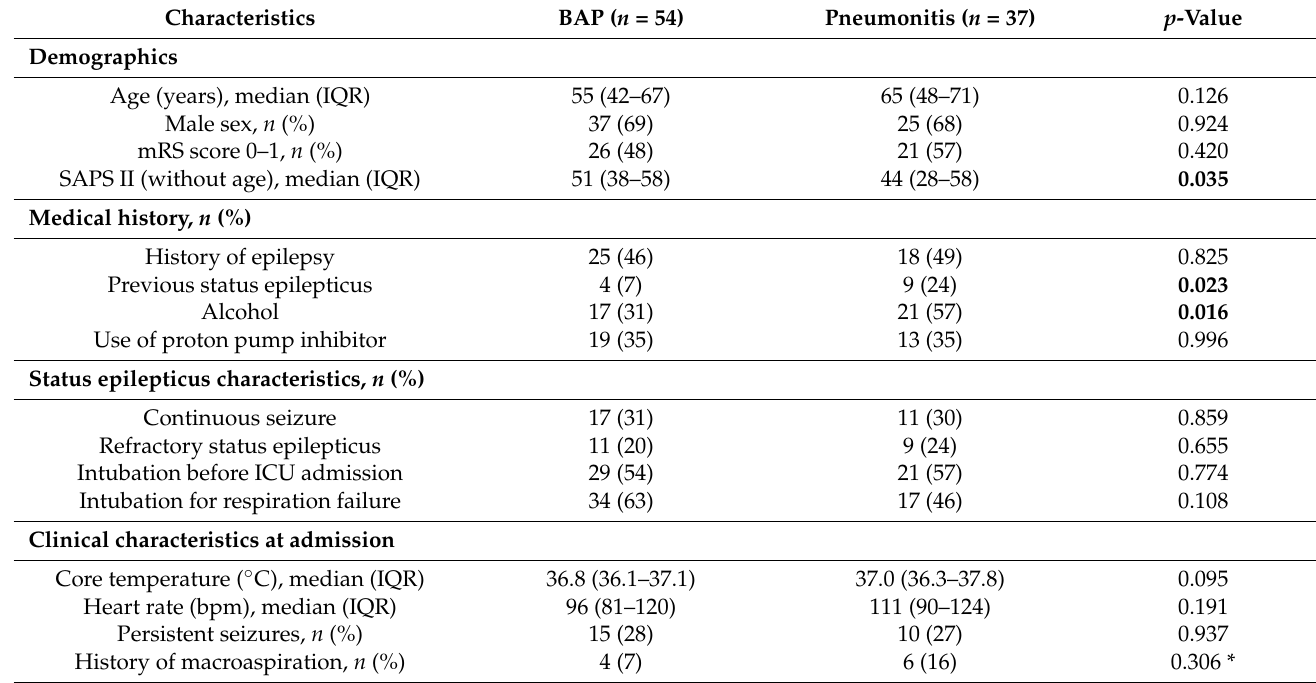
Table 2. Comparison of patients’ characteristics according to the diagnosis of BAP or